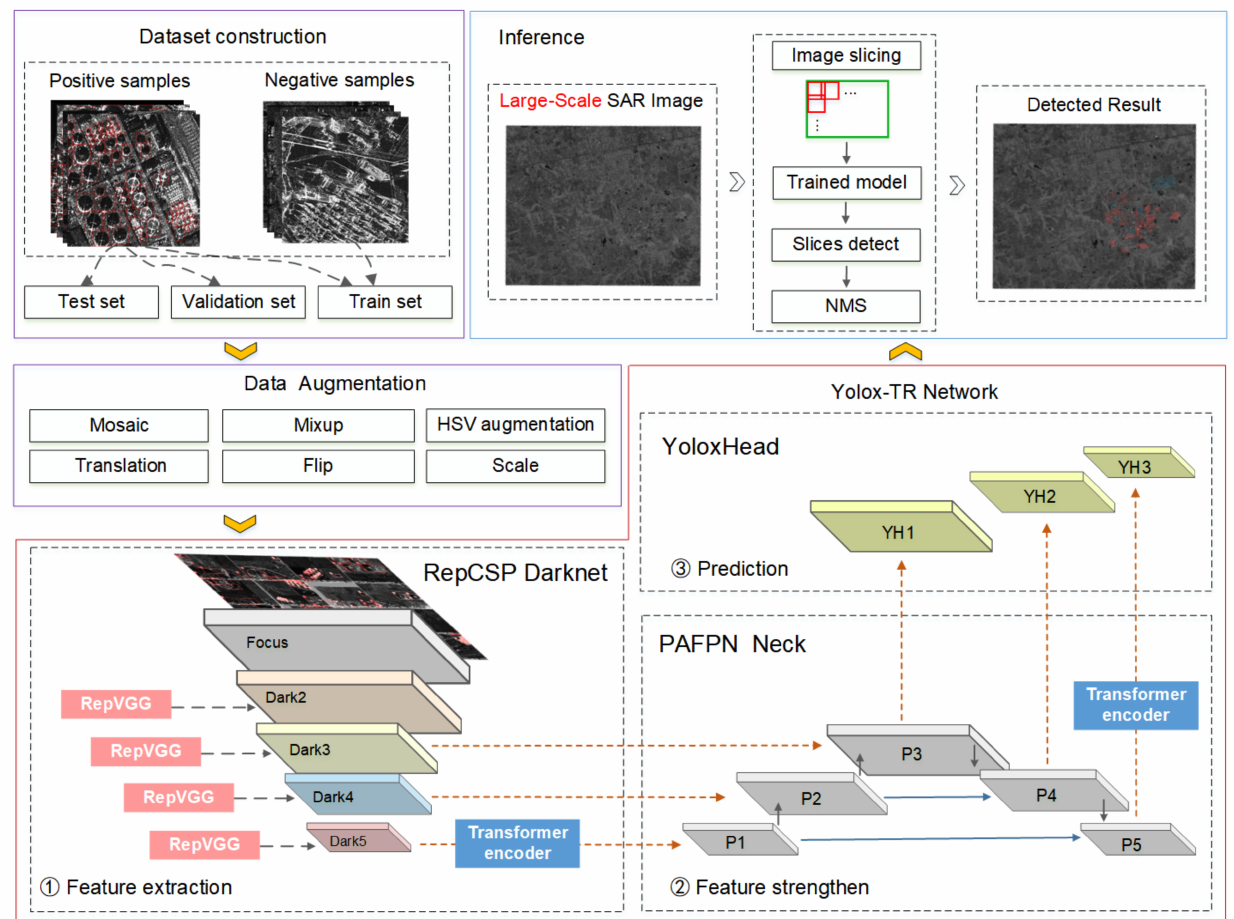
Figure 1. Framework showing the overall methods used in this